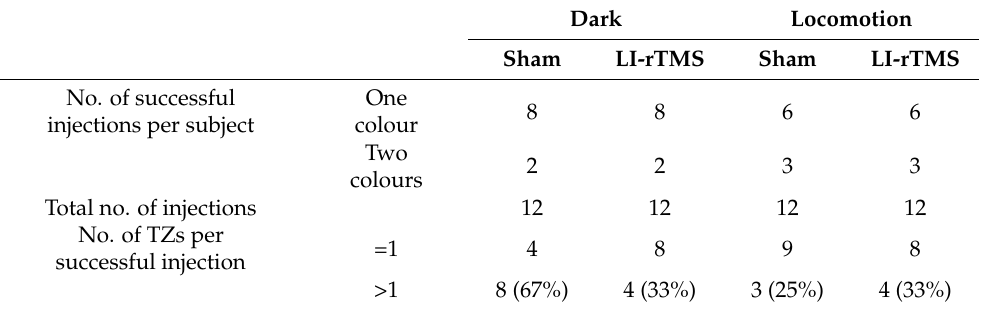
Table 1. Number of successful layer 5 V1 injections and labelled corticotectal TZs in ephrin-A2A5 -/- mice. Two colours refer to the successful labelling of TZs following medial Alexa Fluor 555 and lateral Alexa Fluor 488